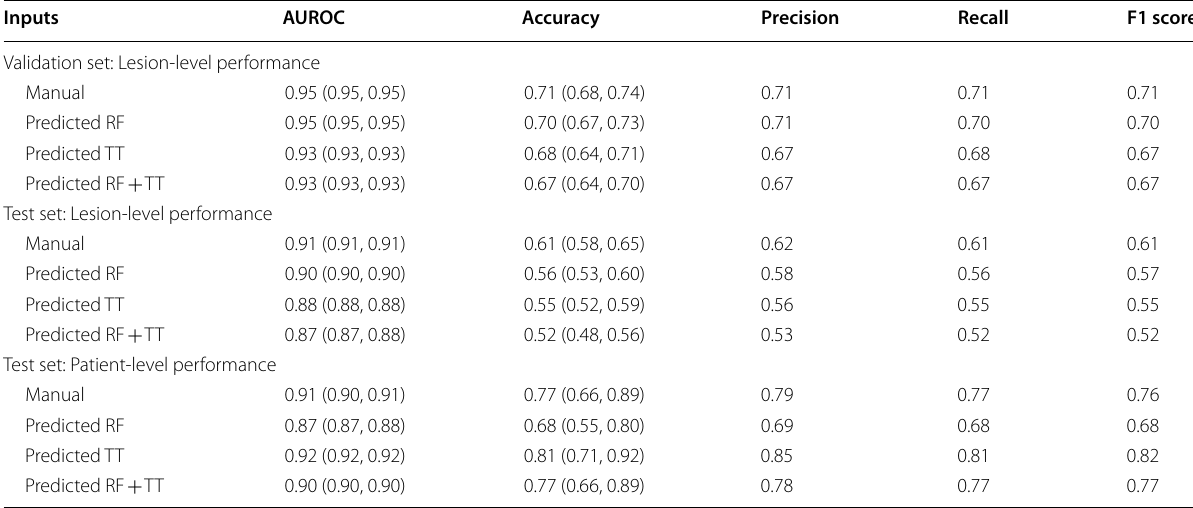
Data in parenthesis correspond to 95% confidence intervals. Manual refers to using the radiomic features extracted from manual segmentations and the manually annotated tissue types as inputs. Predicted refers to using the automatically extracted radiomic features and the automatically predicted tissue types as inputs. AUROC area under the receiver operating characteristic. RF =